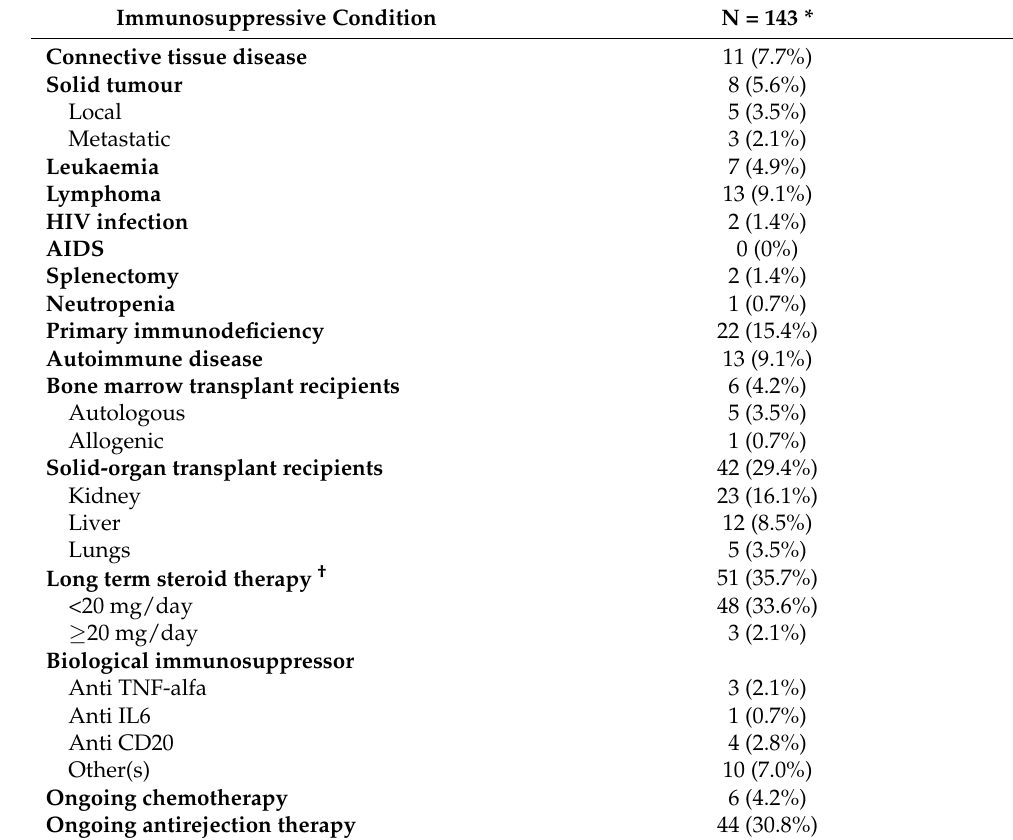
Table 2. Frequency of the conditions defining the immunocompromised